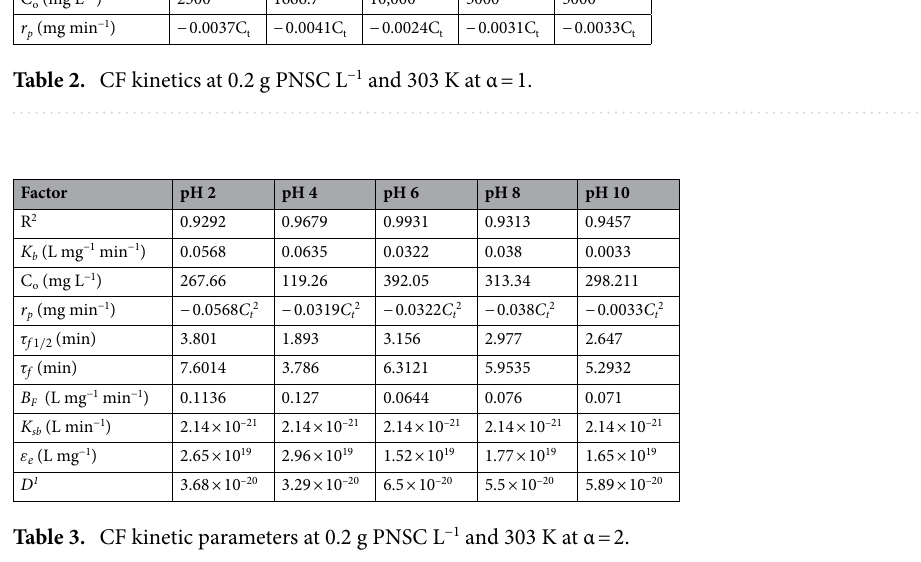
obtained from Fig. 10a,b. Figures 10a, b show the first and second-order CF kinetics at the optimum operating conditions (0.2 g PNSC L −1 and 303 K), obtained by comparing Eqs. 2 and 3, respectively. The summary of the kinetic parameters recorded at the optimum conditions are shown in Tables 2 and 3. The kinetics investigations proved that the PNSC-driven coagulation rate constant increased intermittently from2.4 × 10 –3 L mg min −1 to 4.1 × 10 –3 L mg min −1 with a range of coefficient of determination 0.9333 ≤ R 2 ≤ 0.9796 for first-order (Table 2). The maximum rate constant (4.1 × 10 –3 L mg min −1 ) was recorded at pH 4 and transcends to optimum TD and TSS removal efficiency ≥ 90%. A similar outcome was observed with the second-order CF kinetics (Table 3), with the maximum value of the rate constant (6.35 × 10 –2 L mg min −1 ) with a corresponding R 2 (0.9679) recorded at pH of 4. The least flocculation rate recorded at pH 6 translates to contaminant reduction efficiency ≤ 75%. The kinetic data confirmed that, at the initial stage, the PNSC-driven coagulation dynamics were synergetic with the first-order and second-order kinetic models (where α = 1 and 2). The authors reasoned that the initial stages where the CF dynamics obeyed 1st-order kinetic is attributed to a shift from theoretical expectation but in line with empirical evidence 95,96 . As the coagulation reaction proceeded towards the optimum the dynamics of the PNSC in AQEF adjusted to the 2nd-order (perikinetics flocculation) with a corresponding R 2 ≤ 0.9796. Conse-